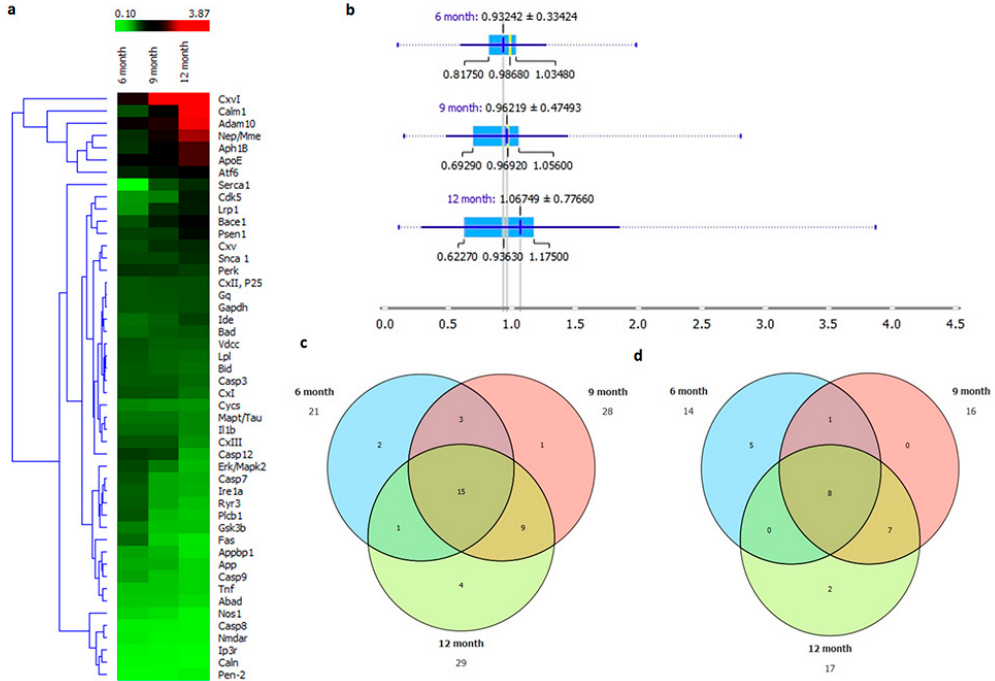
Figure 7. ( a ) Heat map showing comparison of all genes in this study expressed in diseased samples, divided into control, six-, nine-, and 12-month-old APP/PS1 transgenic mice. ( b ) Box plot showing comparison mean with SD of all genes involved in the onset of Alzheimer’s disease analyzed in three age groups. ( c , d ) Venn diagram representing the number of over- and underexpressed genes.